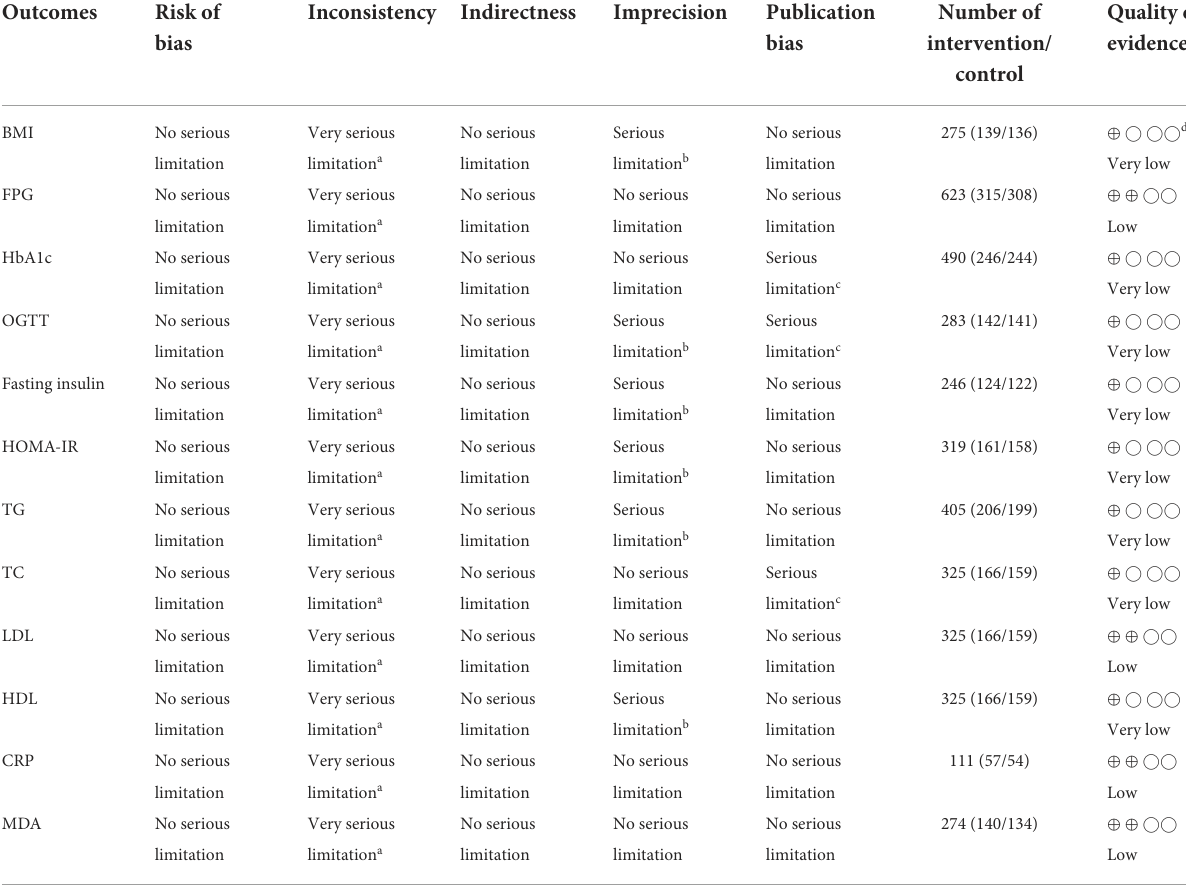
TABLE 4 GRADE profile of NS intake on lipid profile, glycemic indices, body mass index, CRP, and MDA.